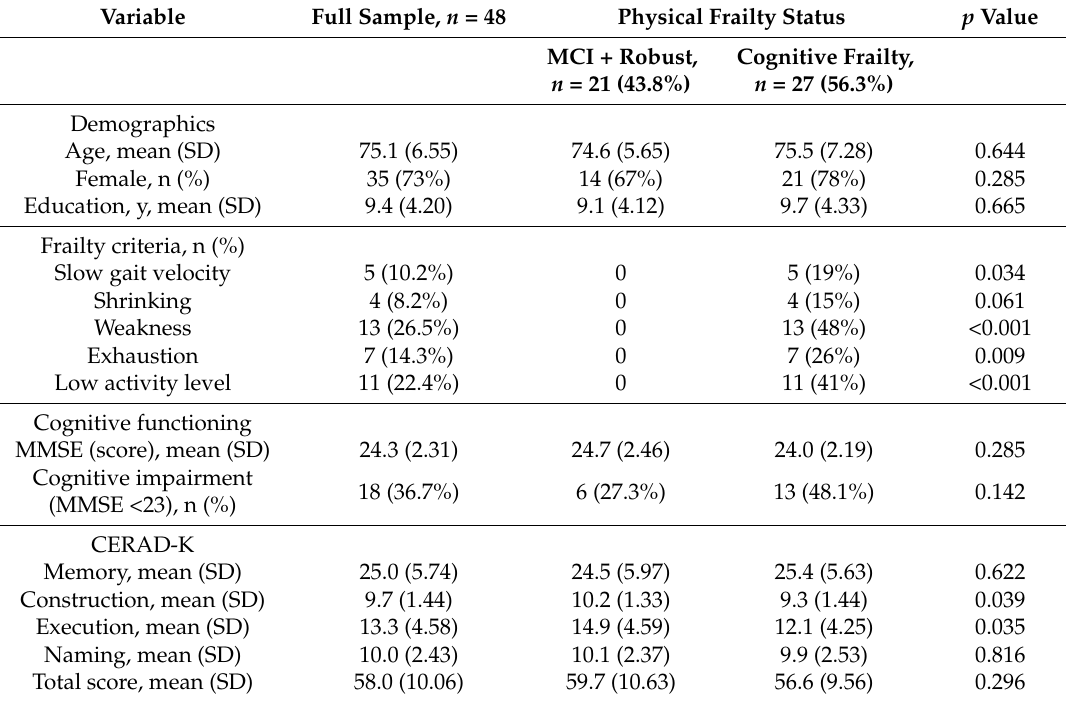
Table 1. Baseline characteristics of study